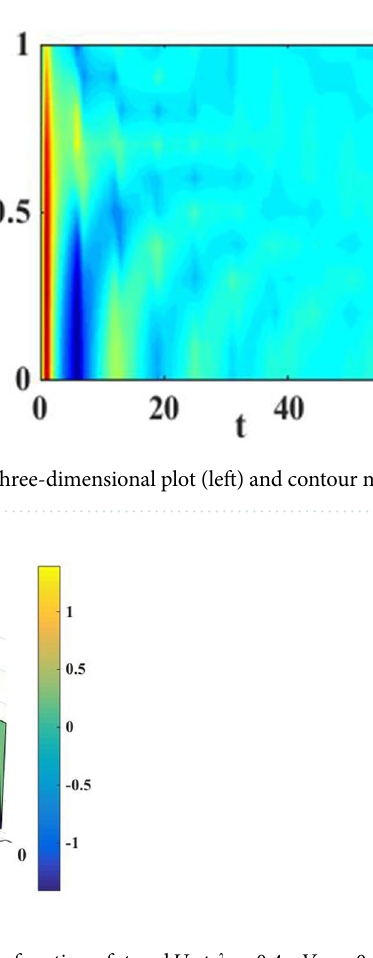
Figure 16. The contour map of the current density as a function of t and U at (cid:31) = 0.4, eV g = 0.6